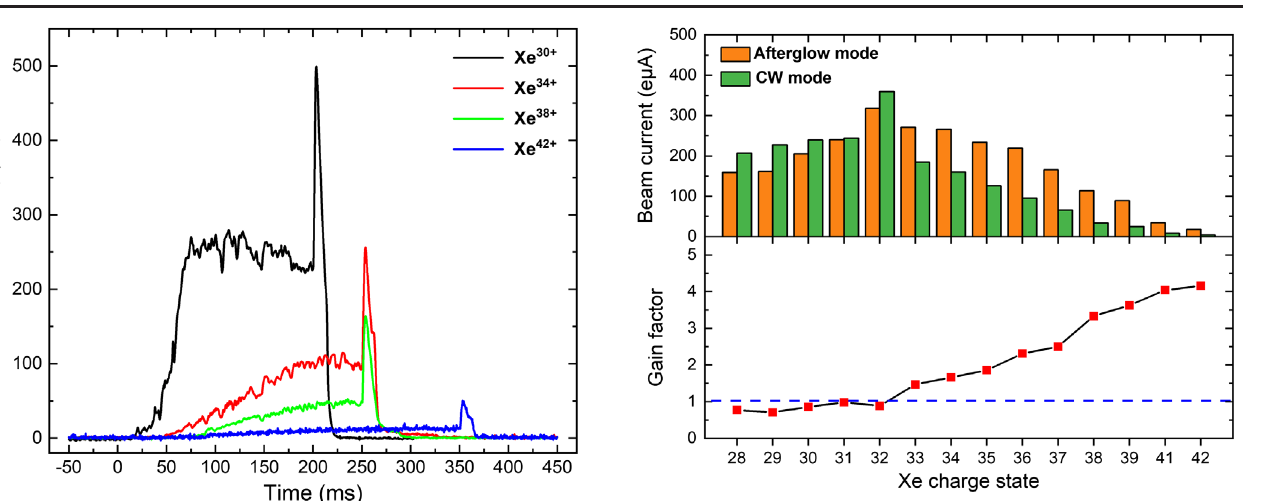
FIG. 8. The optimum afterglow beams for different xenon charge states. The microwave power is turned on at 0 ms.